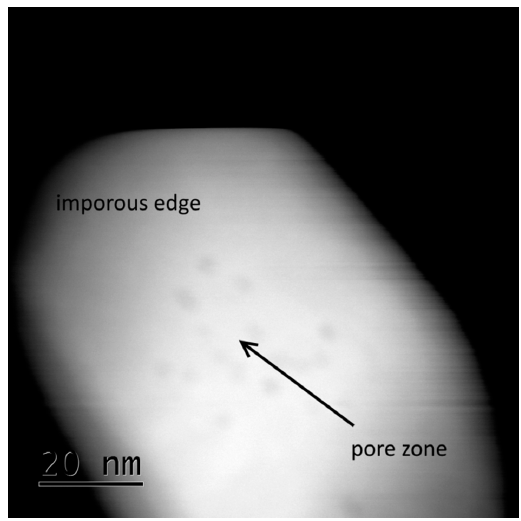
Figure 4. TEM images of 7 YSZ powder indicating YSZ particles containing small pores and smooth edges after calcination at 1373 K for 2 h.